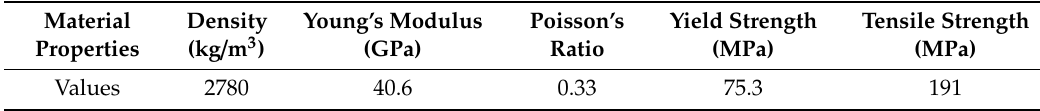
Table 1. Mechanical properties of 2024-O aluminum alloy sheet.